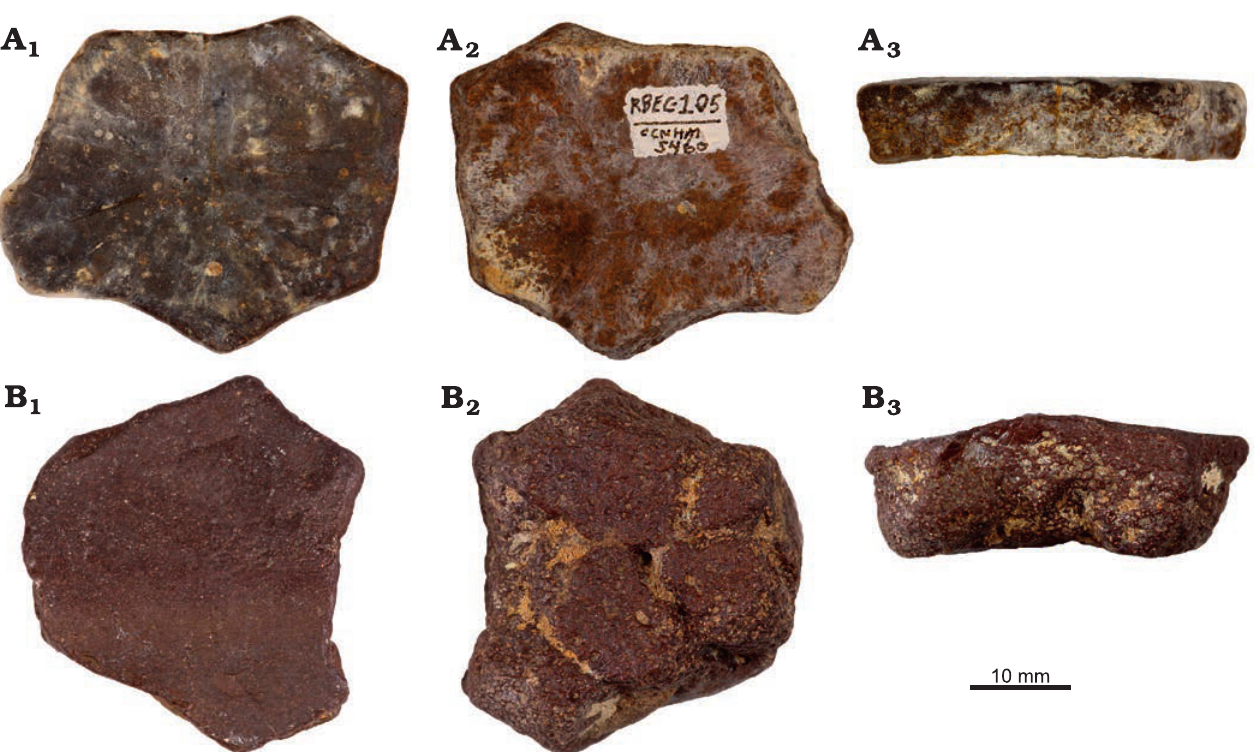
Fig. 5. Ossicles of leatherback turtle cf. Psephophorus sp. from Oligocene of South Carolina, USA. CCNHM 5460 ( A ) and CCNHM 5543 ( B ), in dorsal (A 1 , B 1 ), visceral (A 2 , B 2 ), and sutural (A 3 , B 3 )